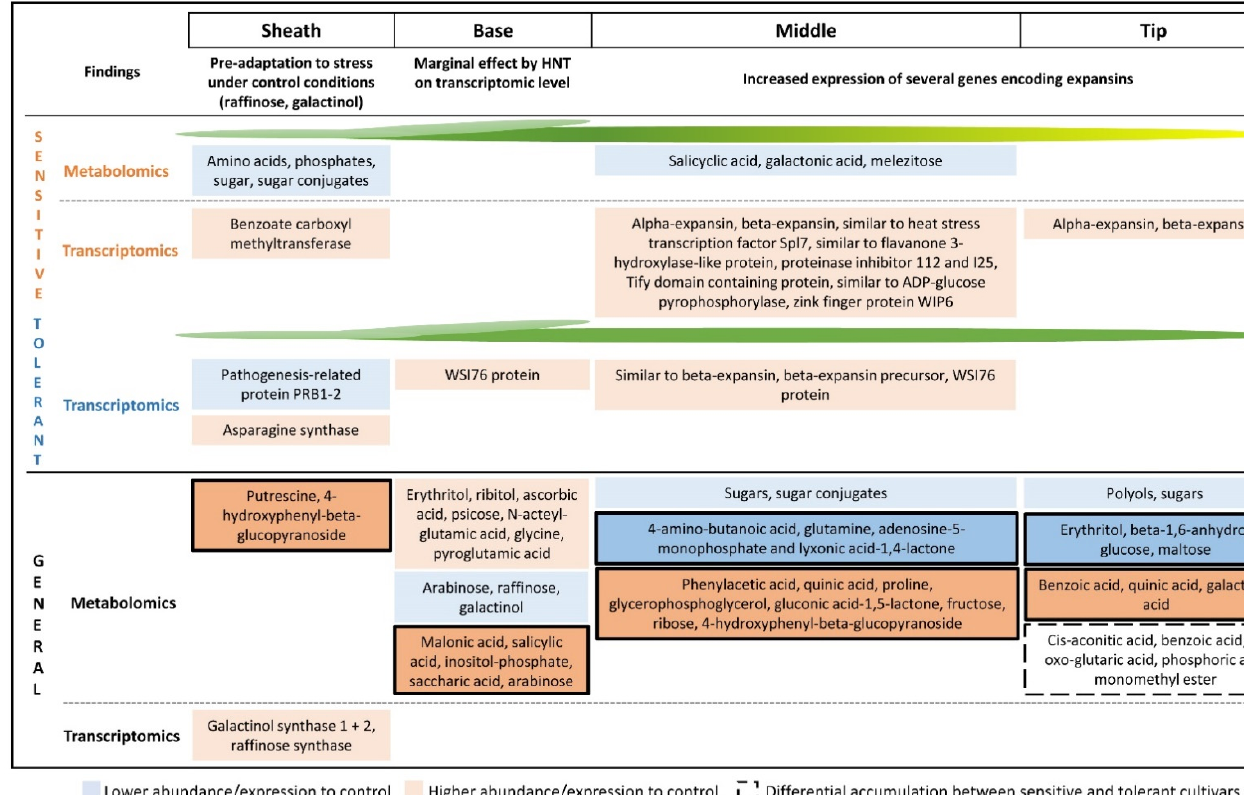
Figure 9. Overview of main metabolic and transcriptomic changes in the leaf sheath and segments of the leaf blade in sensitive or tolerant cultivars under HNT conditions. General changes under HNT in all investigated cultivars are shown at the bottom of the figure.